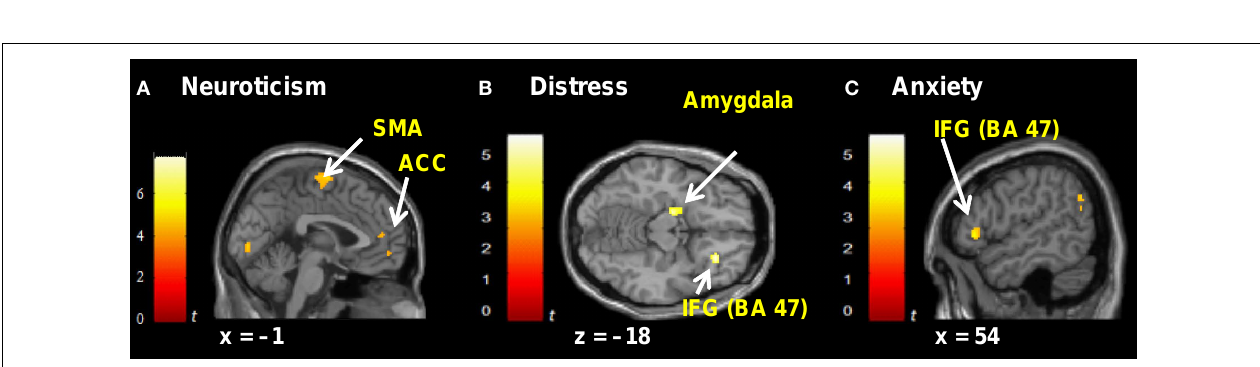
FIGURE 4 | Correlated dispositional measures and rostral PFC activity during observation of avatar in pain. The activation of the rostral PFCin the pain vs. non- pain contrast is shown in (A) , and, as found in the subsequent analysis, the prediction by scores of Personal Distress (B) , Neuroticism (C) , and Fantasy (D) of change in hemodynamic response in rostral PFC during observation of the avatar in pain, superimposed on the coronal sections of the single subject structural MNI